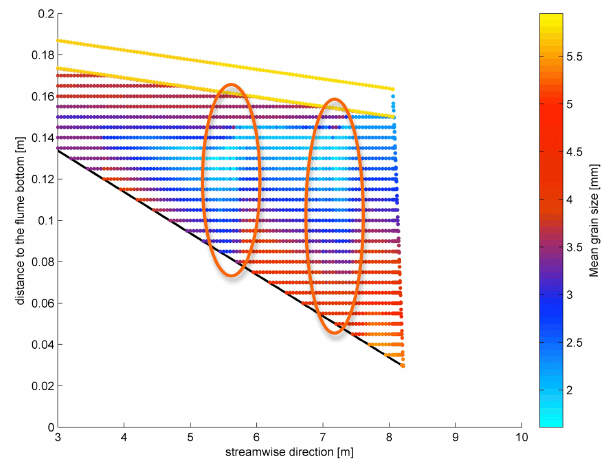
Figure A2. Numerical stratigraphy of the deposit for the Ashida and Michiue simulation. The dots represent the grid nodes, and the color scale associated with the geometric mean diameter in millime- ters of the substrate layers is the same as in Fig. 8. The black line represents the top of the initial layer of parent material. The orange ovals indicate the stratigraphic record emplaced when the stacked small deltas reach the brinkpoint of the initial deltaic deposit. The geometric mean diameter of the parent material is 3.43mm. The re- sults are obtained using the Ashida and Michiue grain-size-based bedload relation, which is not appropriate for modeling the Ferrer- Boix et al. (2013)